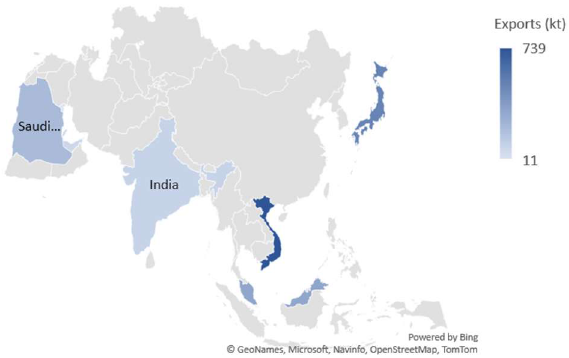
Figure 9. Top importers of Sri Lankan crops based on trade data 2010–2020. In 2020, Sri Lanka exported a total of 212 kt of wheat (refer to Figure 10). According to the data collected between 2015 and 2020 [97–100], more than 60% of total export goes to Vietnam (64.8 kt) and Japan (63.5 kt). Sri Lanka’s remaining top export partners are Malaysia, Singapore, and Maldives. The export of wheat to India (+37%) increased rapidly from 2015 to 2020, and the fastest decline is United Arab Emirates at a rate of − 59%. In 2020, Sri Lanka exported 17.7 kt of banana to Saudi Arabia and Qatar mainly, covering 75% of the total export of banana. The remaining 18% was exported to United Arab Emirates, Kuwait, and Bahrain. Export of banana to Kuwait increased at a rate of +26% from 2015 to 2020, while export to United Arab Emirates decreased by − 29%. This causes concerns since United Arab Emirates is the third-largest export partner of Sri Lanka for bananas. From 2015 to 2020 (8.2 kt), the total export of pepper deceased by almost 50%. Sri Lankas’s main export partner for pepper is India, covering more than 80% of total export. The remaining 20% is exported to Germany, United States, Spain, China, and more. One of the export partners of Sri Lanka is Saudi Arabia, but exports to this country have decreased by 80% in the last 5 years. After a peak in 2013 (11.5 kt), the export of tobacco reduced significantly by 2020; Sri Lanka exported 1.8 kt of tobacco. The top export partners of tobacco from Sri Lanka are Hungary, Belgium, Italy, United States, and Germany. The fastest growing export partners are Belgium (+22%) and Hungary (+14%). Export of onion from Sri Lanka has increased by 1000 t, and 33% of total export of onions goes to Kuwait (402 t). Remaining top export partners for this product are: United Arab Emirates, India, and Qatar, which covers more than 47% of total export of onion. Export of onion to Bahrain, Canada, and United Arab Emirates has increased at the minimum rate of +130% (2015–2020). The fastest declining export partner is Germany at a rate of − 30%. The export of pineapple from Sri Lanka has decreased by 12% since 2013. The main export partners of pineapple from Sri Lanka are United Arab Emirates and Germany, at 41% of total export of pineapple, and 34% of total export of pineapple from Sri Lanka goes to countries such as Germany, Netherlands, Austria, and Maldives. Export of pineapple from Sri Lanka to Japan is rapidly increasing at a rate of +33%, and export to Bahrain and Maldives is rapidly decreasing at a minimum of − 48%. Export of beans decreased from 863 t (2012) to 85 t (2020), and 53% of total export of beans goes to Turkey. The remaining 47% is covered by India, United Kingdom, Maldives, and Cyprus. Export of beans to Cyprus has increased +73% from 2015 to 2020. In 2020, Sri Lanka exported a total of 241 t of lemon and lime. This product is mainly exported to Saudi Arabia and United Arab Emirates, covering 85% of total export. Qatar, Maldives, and Germany are covering 13.3% of total export. From 2015 to 2020, export of lemon and lime has increased by +18%, and export to Kuwait and Maldives has increased at a minimum rate of −